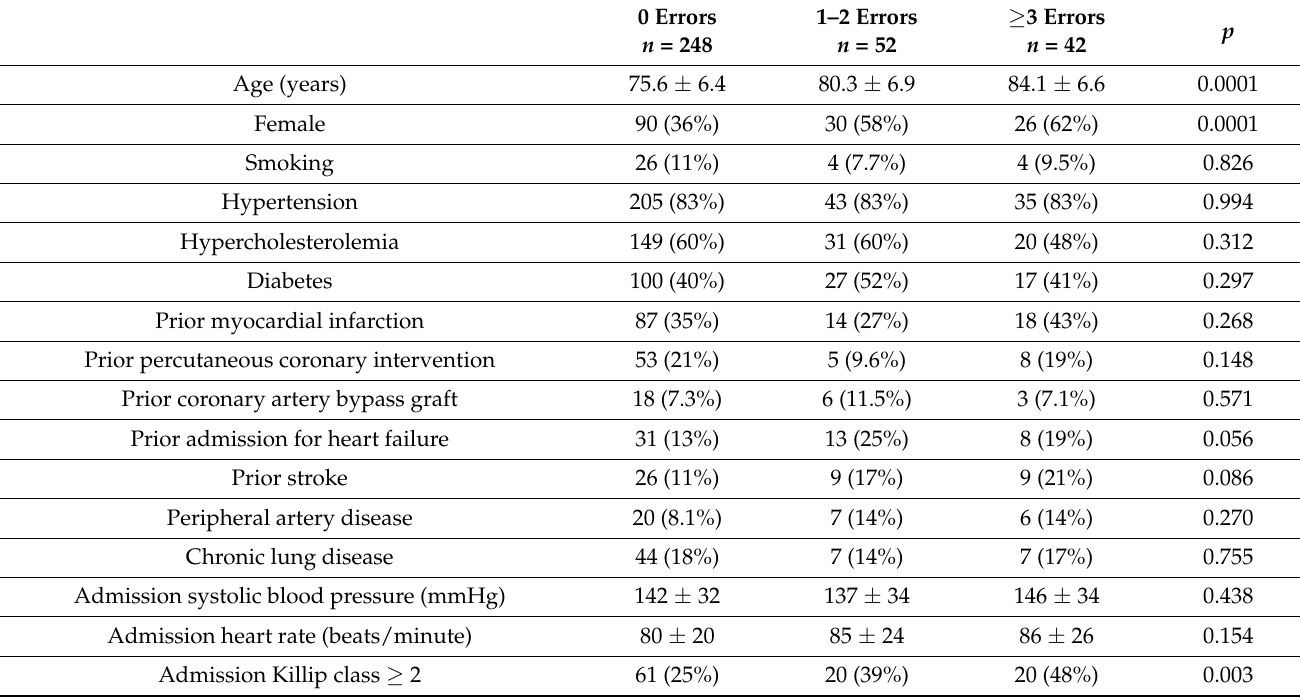
Table 3. Baseline patient characteristics across cognitive dysfunction categories according to the results in the